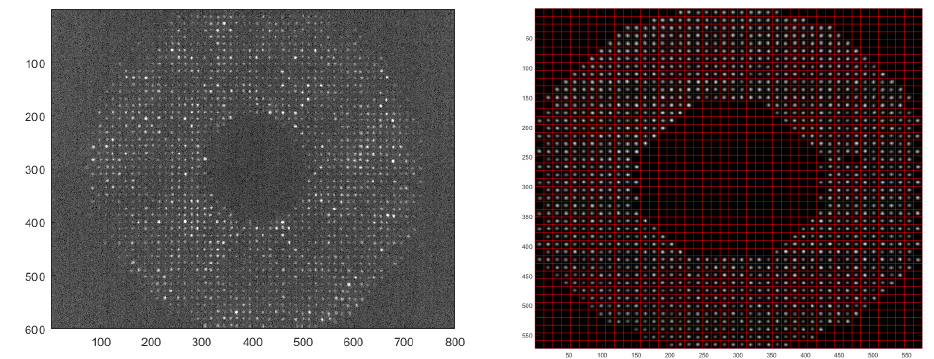
Figure 4. Example of a 600 × 800 pixel data frame compared to a 572 × 572 pixel cropped frame with the background subtracted, mask applied, and auto-focused. Blurred subapertures are also masked. Red 13 × 13 pixel boxes represent the tracking